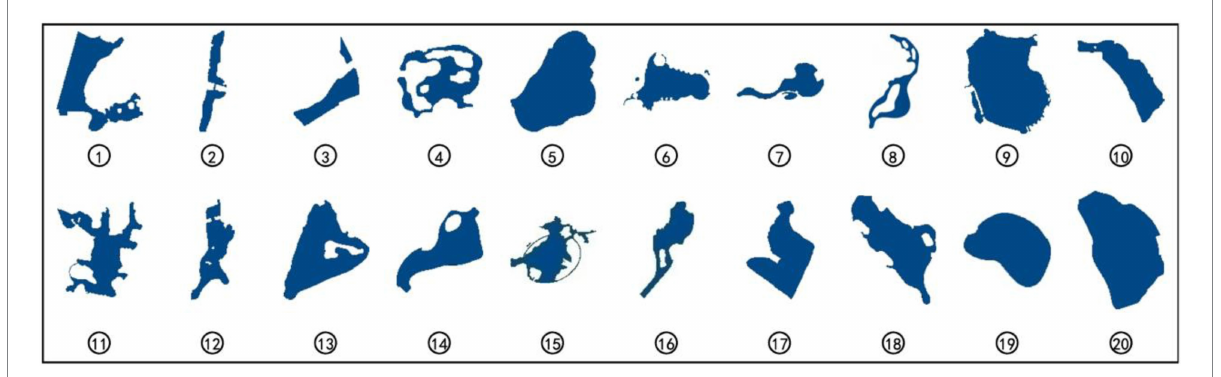
FIGURE 2 Planar shape of urban public space water